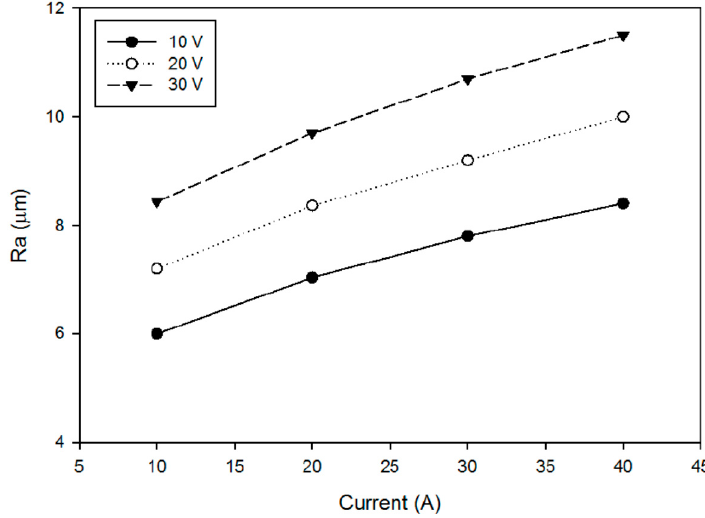
ff ects of discharge current and voltage on surface Figure 8. Effects of discharge current and voltage on surface roughness. Figure 8. Effects of discharge current and voltage on surface roughness. Figure 8. E